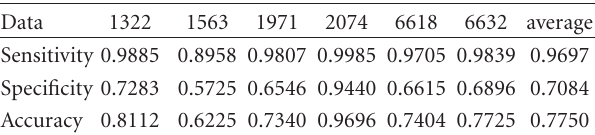
Table 2: The sensitivity, specificity, and accuracy values after AdaBoost